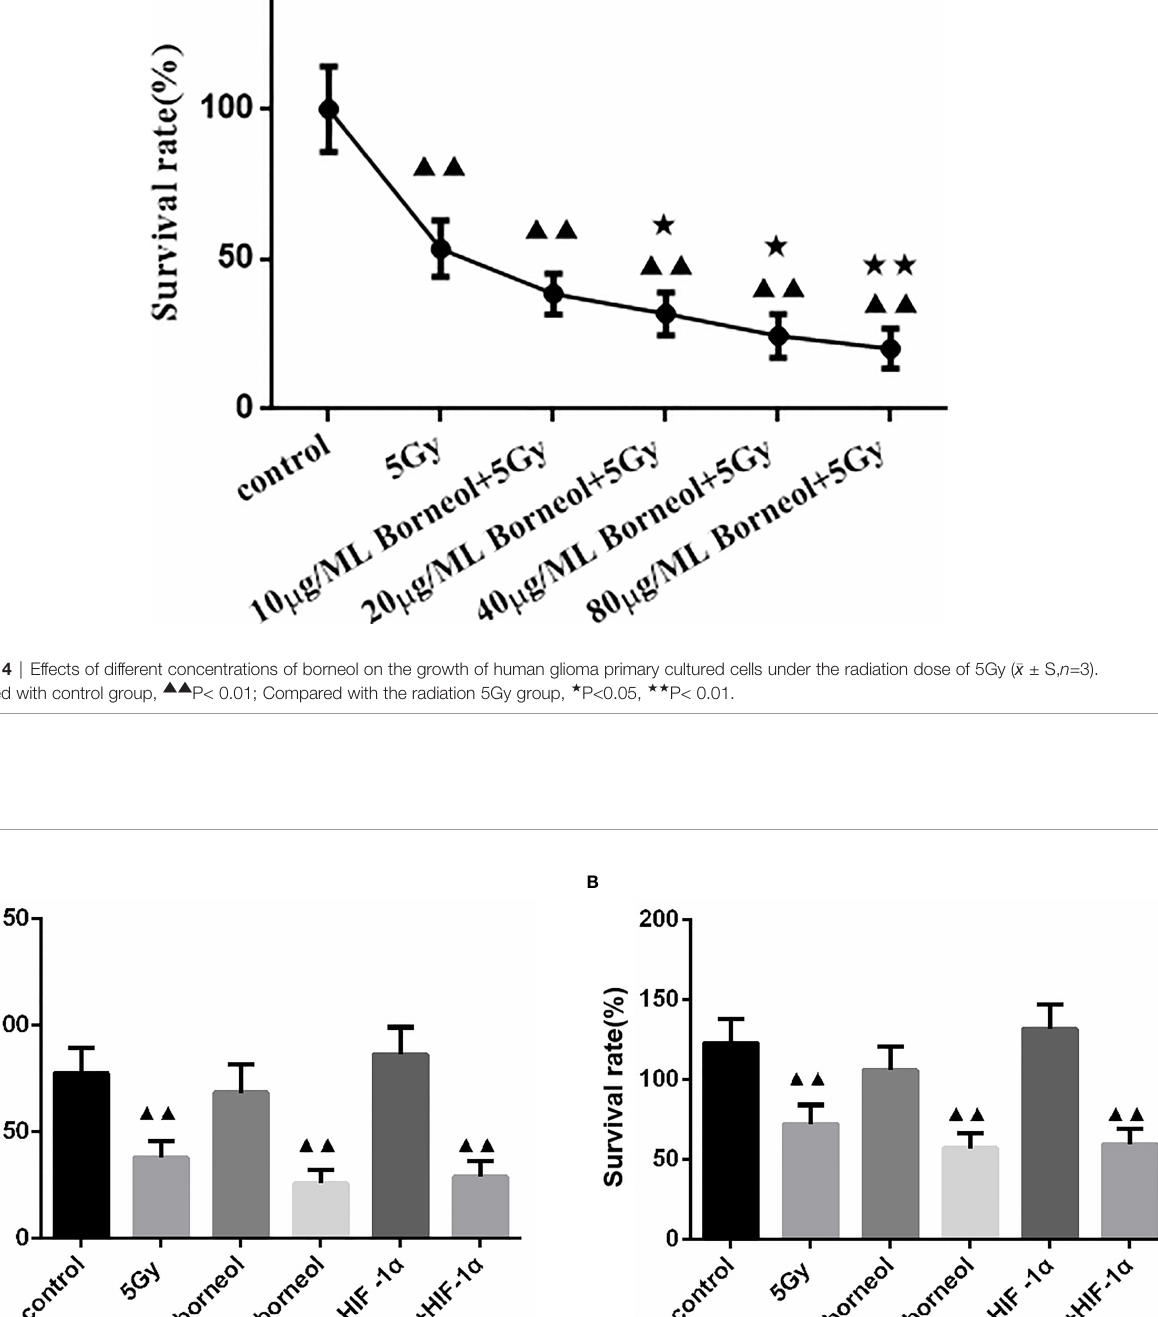
Frontiers in Oncology |